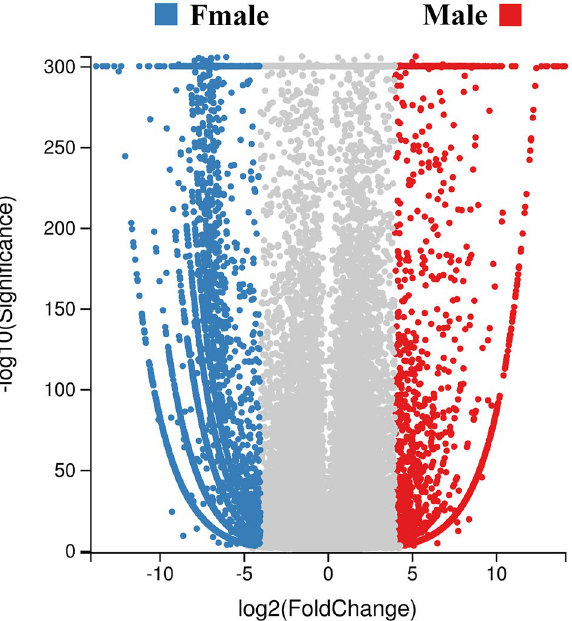
Figure 6. Volcano plot of the gene expression profiles from the libraries for the different sexes. Blue and red dots indicate female-based genes and male-biased genes,